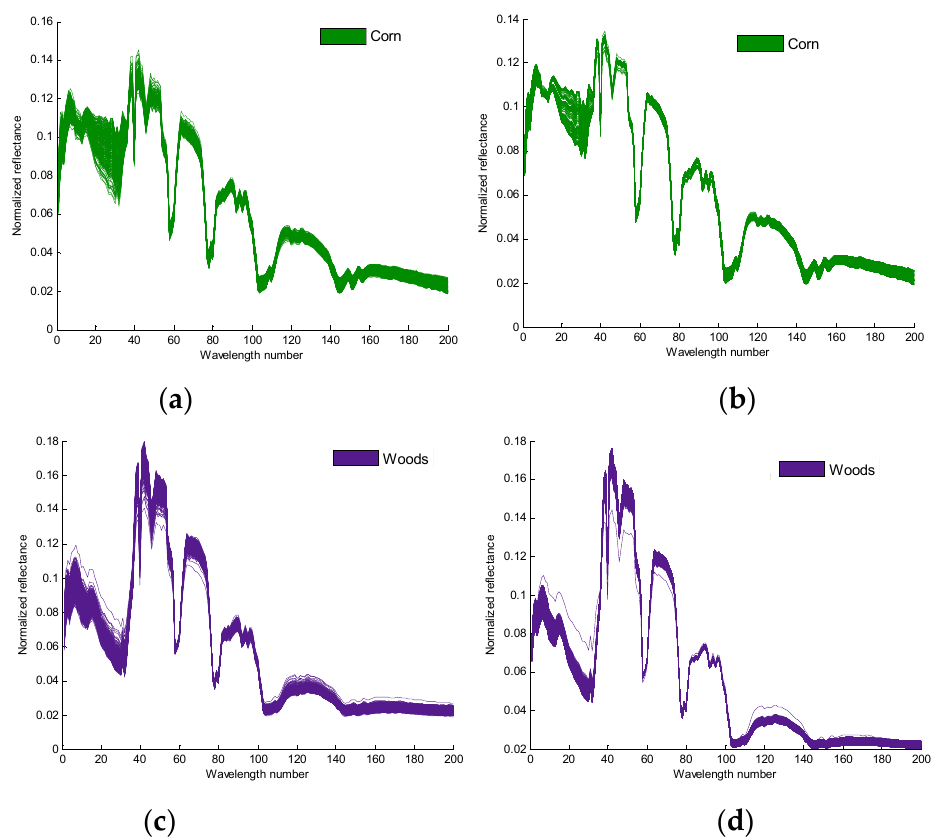
Figure 4 The spectral reflectance of the training samples in the Indian Pines data (a) The training samples (the training samples includes 16 classes, each class randomly takes 5 training samples, each color represents a class ） , (b) The 3 times augmented training samples